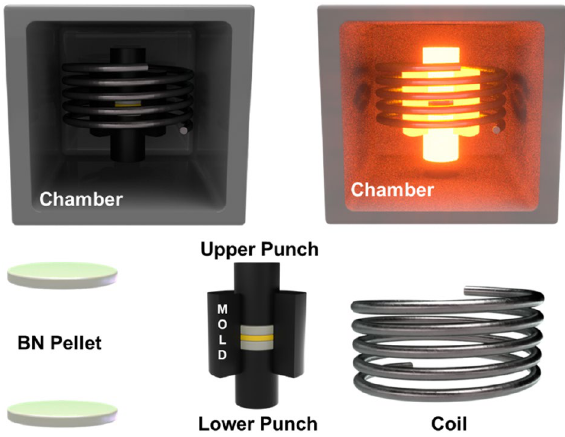
Figure 1. Schematic of HPF equipment